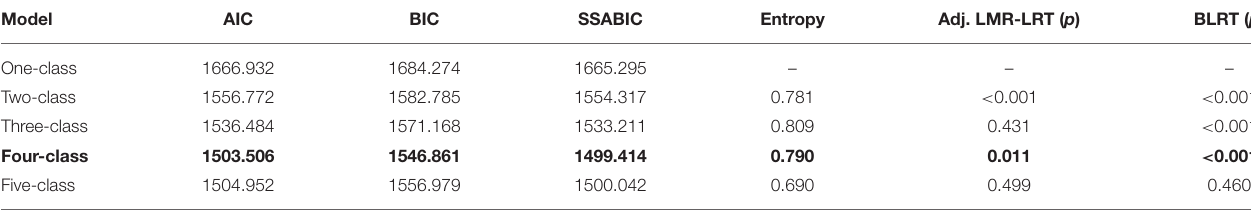
TABLE 1 | Goodness of fit statistics for one- to five-class models of resilient functioning trajectories. Model